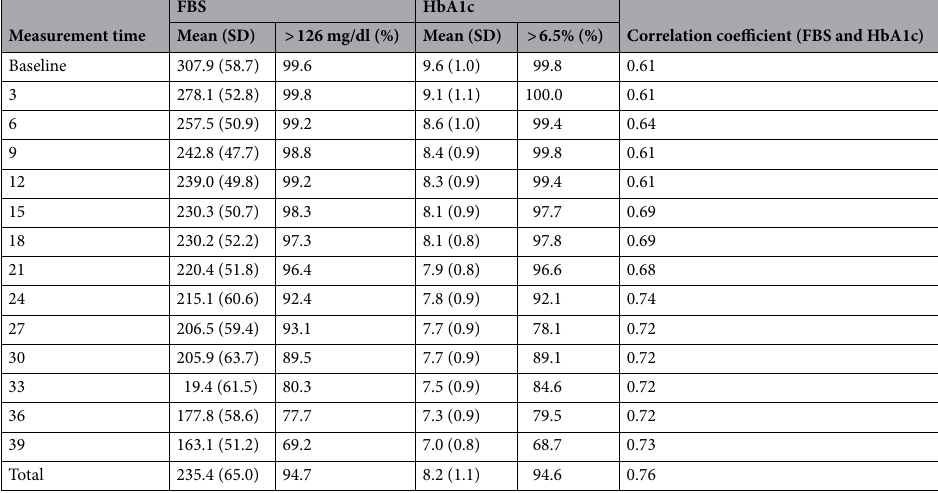
Table 2. Correlation, mean, and standard deviation of FBS and HbA1c in patients by measurement time.